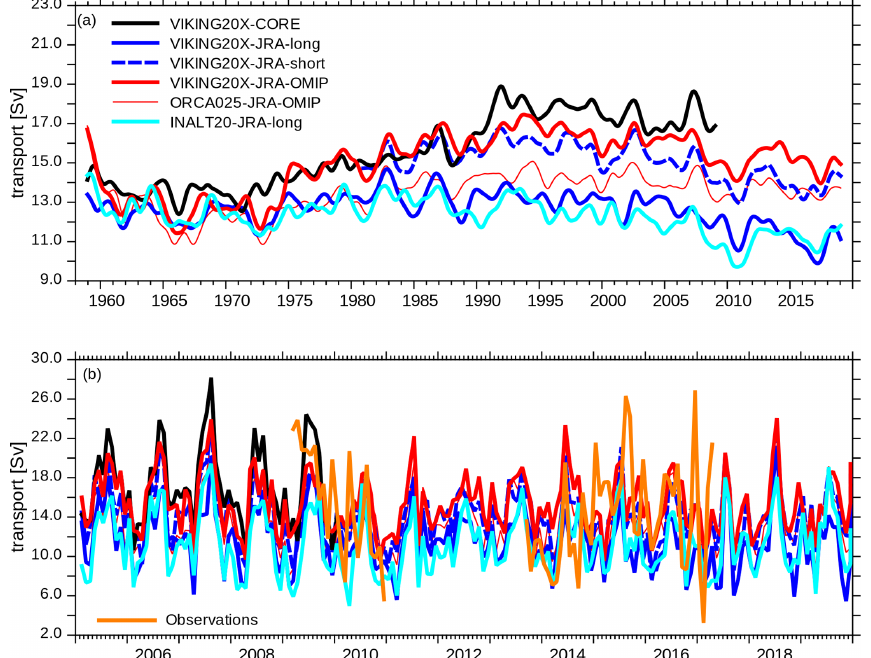
Figure 19. Time series of the AMOC strength at 34.5 ◦ S (a) interannually filtered and (b) monthly averages for the most recent 15 years with observations from Meinen et al. (2018)